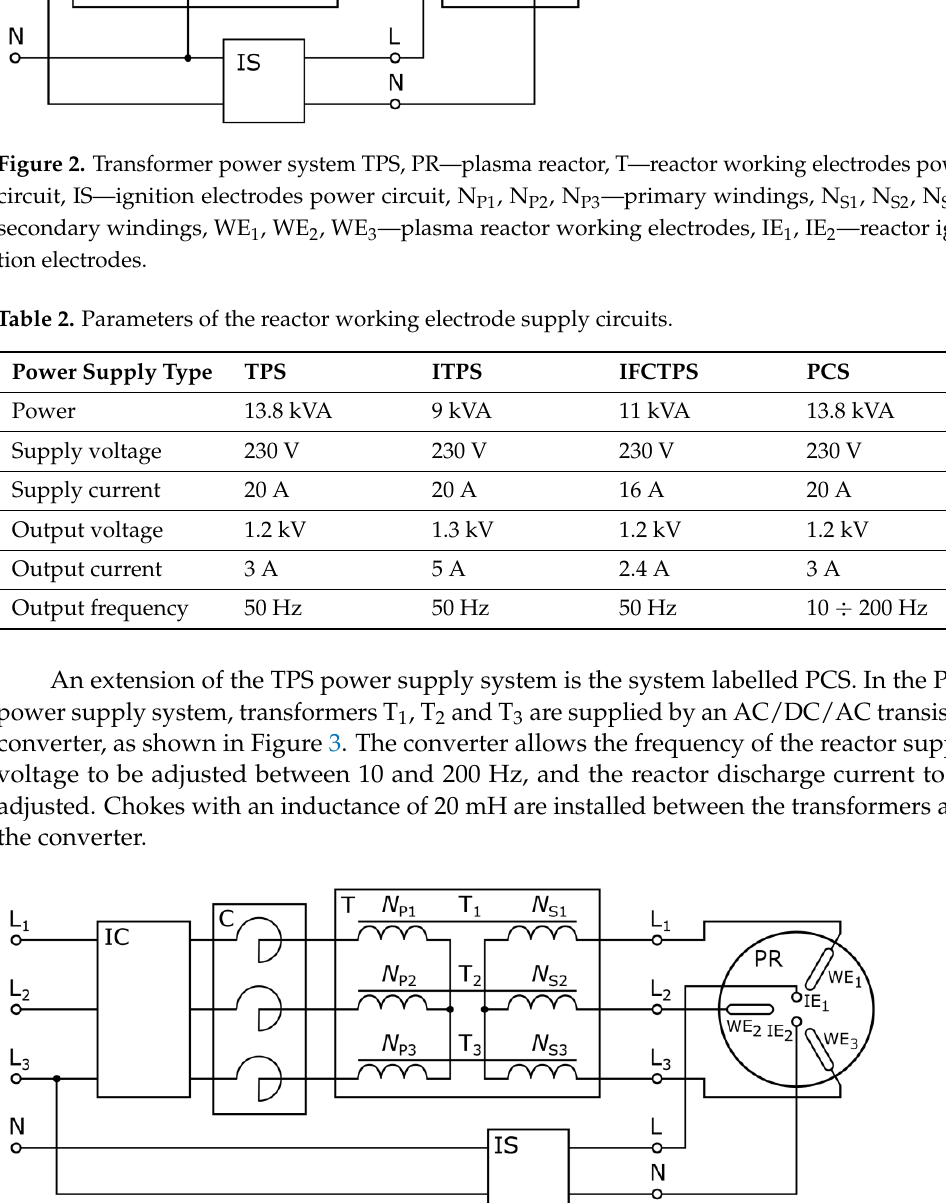
Figure 3. Converter power system PCS, PR — plasma reactor, T — reactor working electrodes power circuit, IS — ignition electrodes power circuit, C — chokes, IC — AC/DC/AC transistor converter, N P1 , N P2 , N P3 — primary windings, N S1 , N S2 , N S3 — secondary windings, WE 1 , WE 2 , WE 3 — plasma reactor